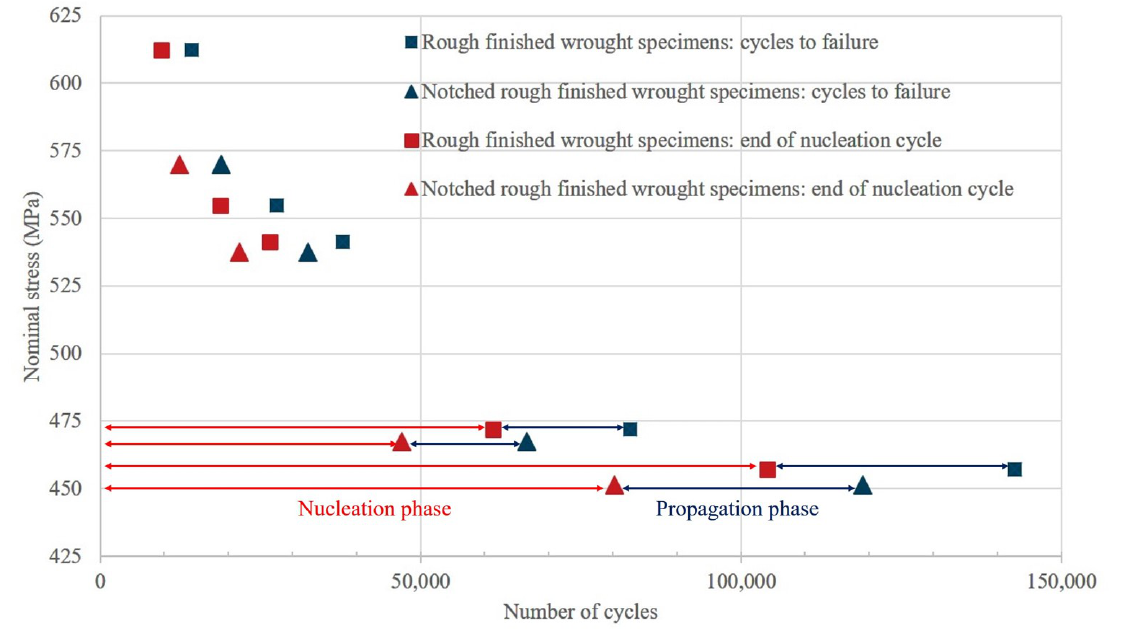
Figure 16. Nucleation and propagation phase of rough finished wrought and notched rough finished wrought